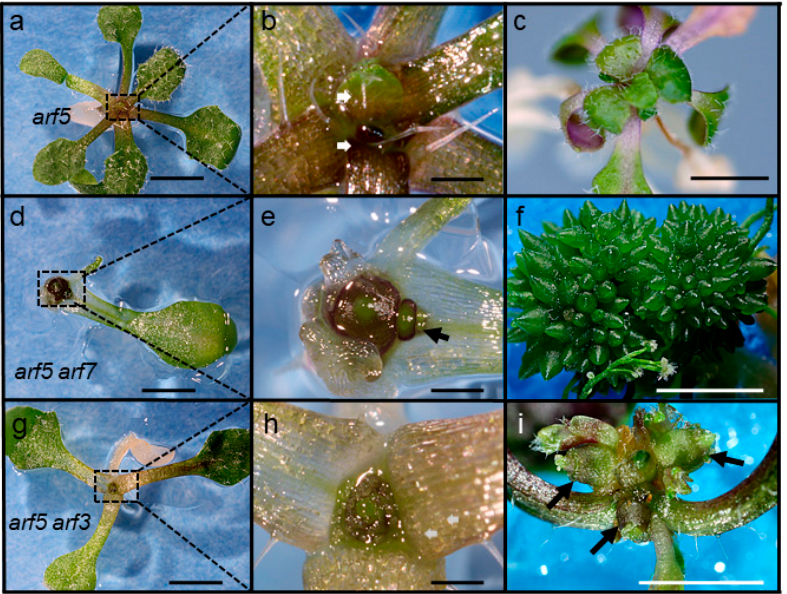
Figure 7. Leaf initiation defects in arf5 arf7 and arf5 arf3 double mutants. ( a – c ) arf5 , ( d – f ) arf5 arf7 double mutants, ( g – i ) arf5 arf3 double mutants. Shoot apices from (a, d, g) are enlarged in (b, e, h). Ages are, 21 DPI (a, d, g), 40 DPI (c) and 90 DPI (f, i). Arrows indicate emerging leaf primordia (b), emerging lateral dome (e), dome-like structures (i). Size bars, 300 µm (a, c, d, f, g, i), 100 µm (b, e, h).